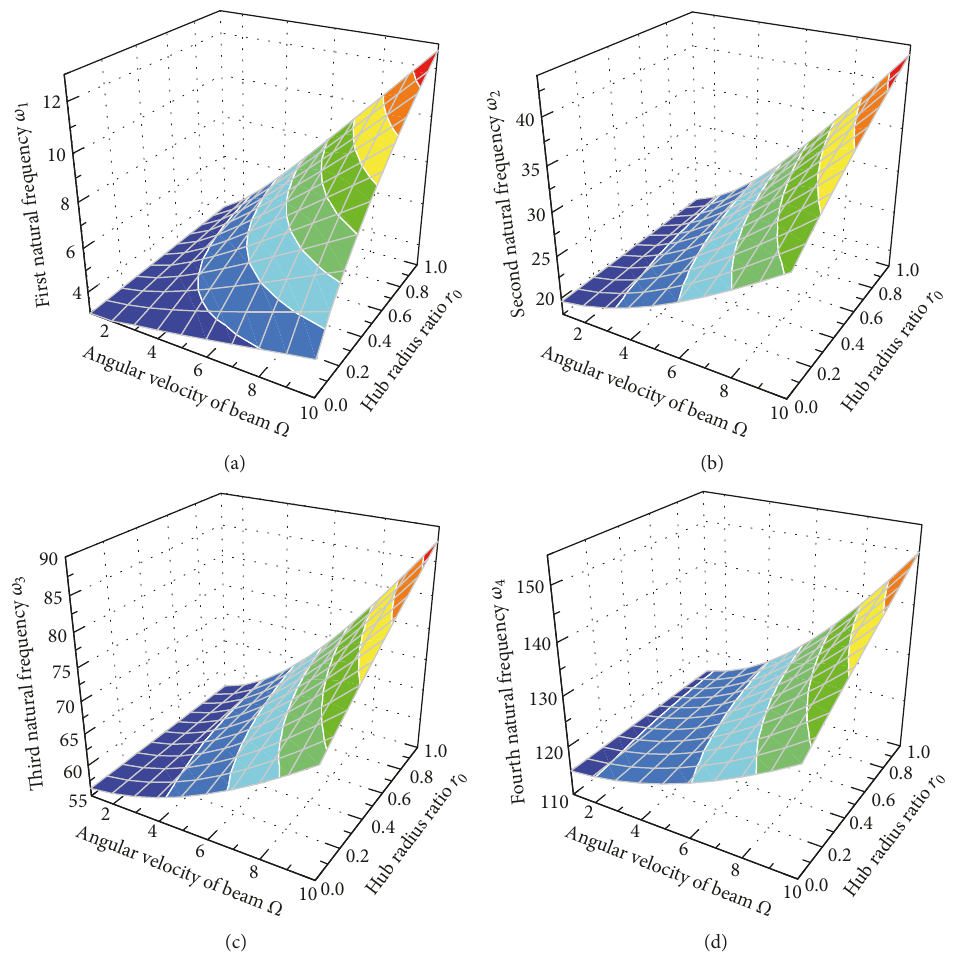
Figure 4: Variations of first four dimensionless natural frequencies 𝜔 𝑖 as functions of rotating angular velocity Ω and hub radius ratio 𝑟 0 for tip mass 𝑚 𝑡 = 0.1 : (a) first natural frequency 𝜔 1 ; (b) second natural frequency 𝜔 2 ; (c) third natural frequency 𝜔 3 ; and (d) fourth natural frequency 𝜔 4